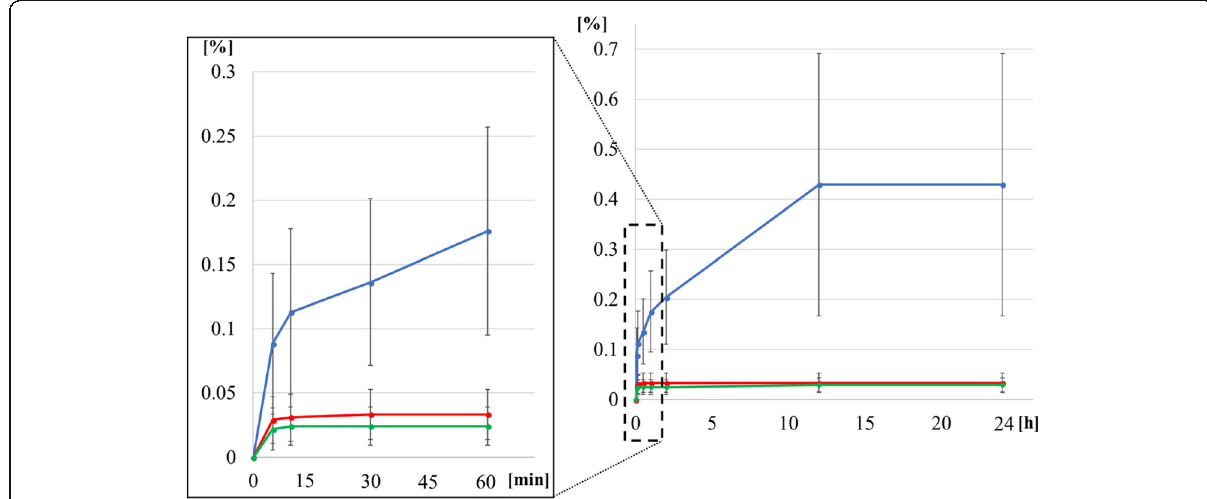
Fig. 3 Mechanical strain ( ε ) of the tendon gels. Mechanical strain ( ε ) of the tendon gels over time on days 10, 15, and 20. On day 10, mechanical strain ( ε ) is stopped 12 h later. On days 15 and 20, the mechanical strain ( ε ) is stopped only 5 min